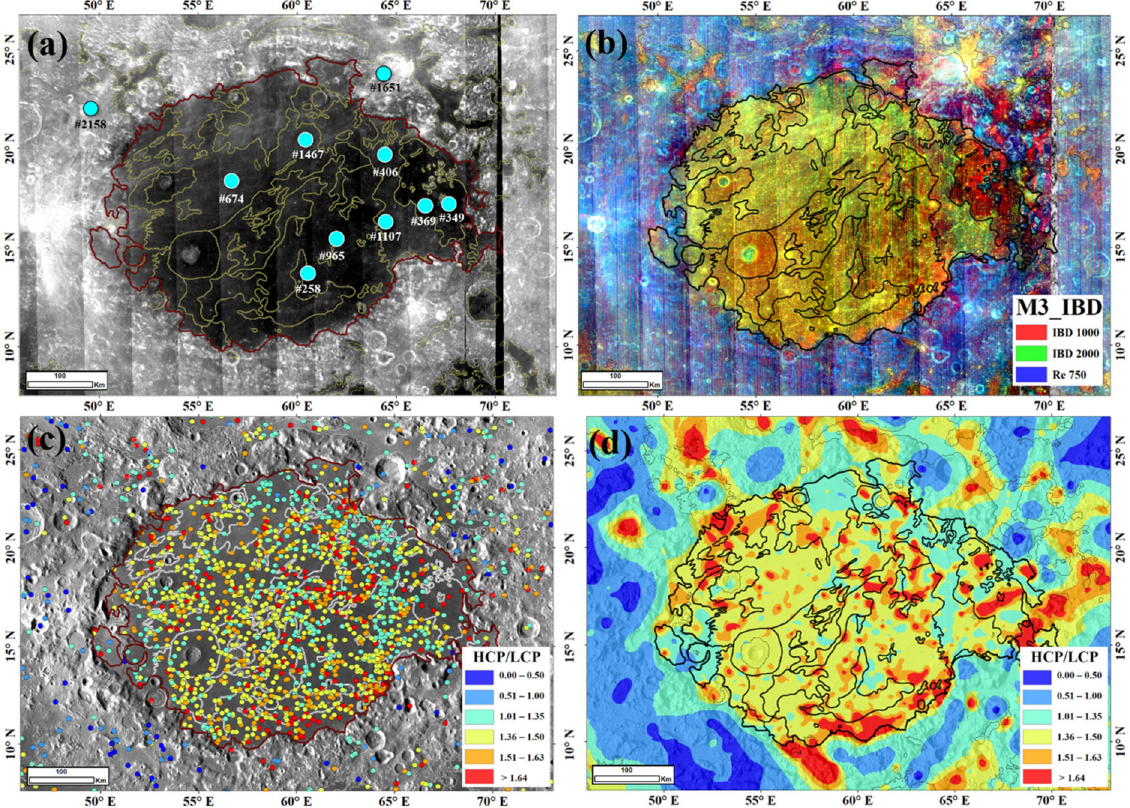
Figure 9. ( a ) The M 3 reflectance map at 750 nm and ( b ) the RGB map using IBD1000 (red), IBD2000 (green), and Re 750 (blue) of the Crisium basin. The labeled spectra of these sky-blue points are shown in Figure 10 ( c ) M 3 spectral survey of small craters in the Crisium basin and the spatial distribution of HCP/LCP ratios derived from the MGM method. ( d ) Pyroxene map based on the interpolation of ( c ) using Kriging interpolation